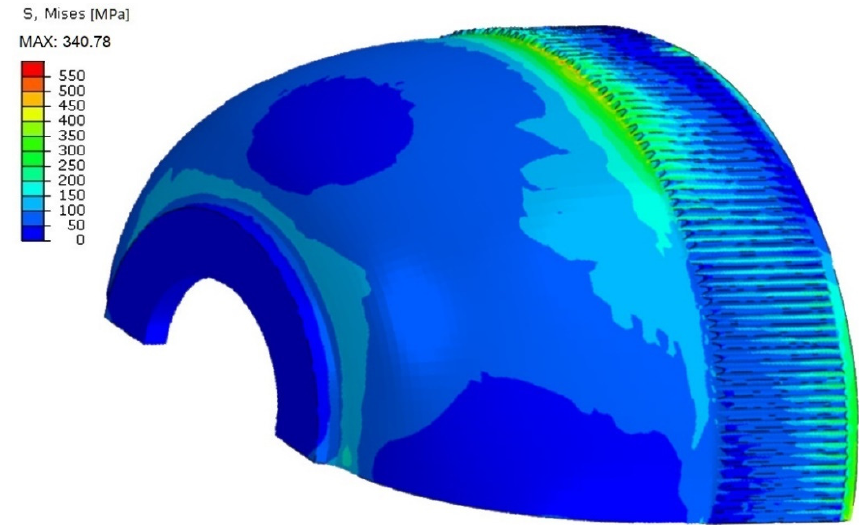
Figure 13. The distribution of the stresses in the flexspline model—variant IX.